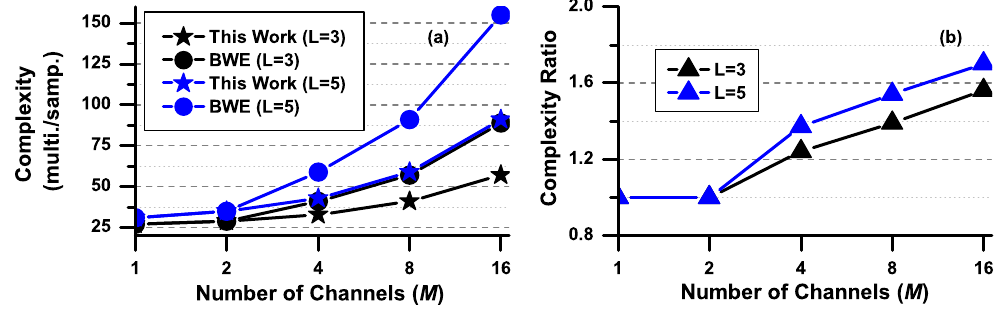
Figure 13. ( a ) Complexity and ( b ) complexity ratio under different numbers of channels and orders of the nonlinearity. BWE, bandwidth efficient.